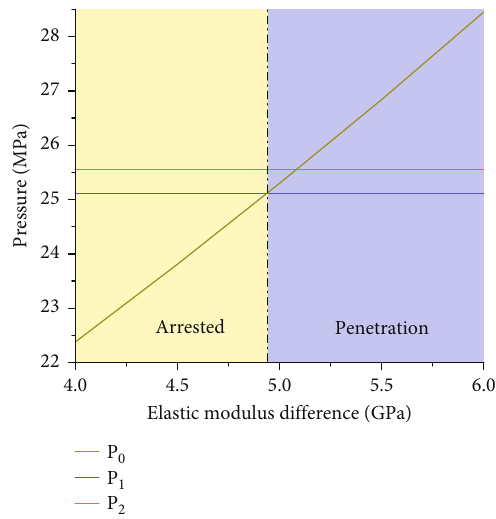
ff erent elastic moduli